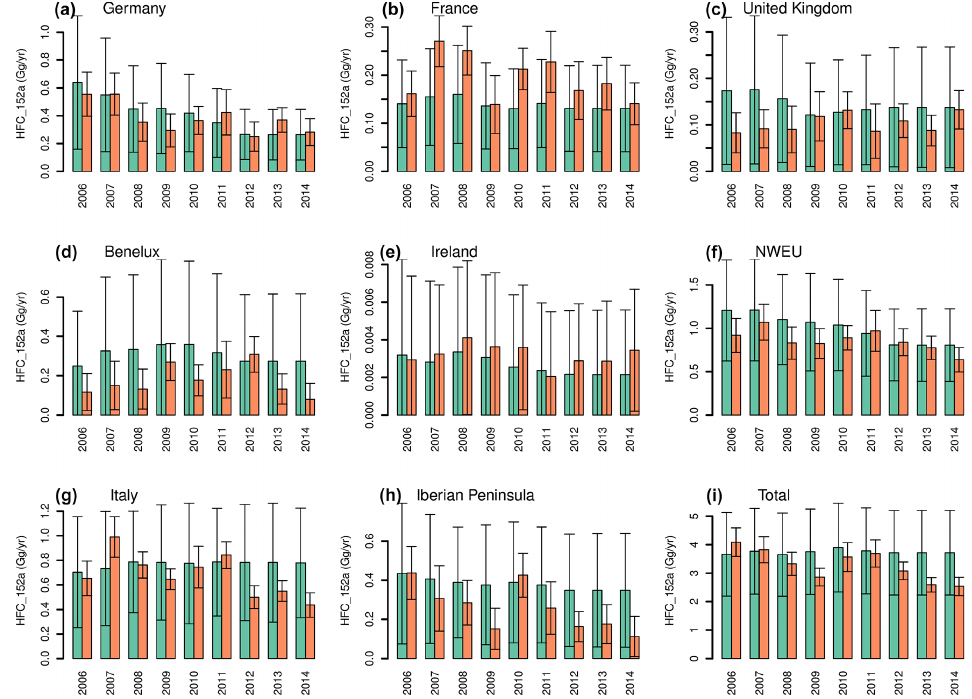
Figure 9. HFC-152a emission estimates for different European regions using the Bayesian regional inversion (orange bars) and prior esti- mates as reported to UNFCCC (green bars). Error bars indicate 2 σ confidence levels. Total prior uncertainties were set to 20% of the total domain emissions, which may result in different levels of relative uncertainty for each country/region. Note that prior estimates for Italy were taken from EDGAR instead. Prior values for 2012 were repeated for each region after 2012.